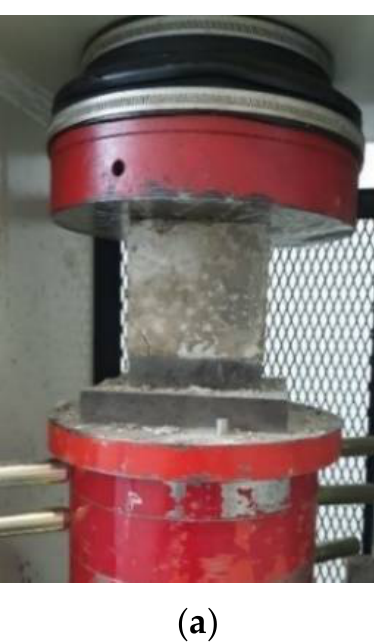
Figure Figure 7. Geopolymer concrete specimen during ( a ) compressive and ( b ) splitting tensile strength testing.